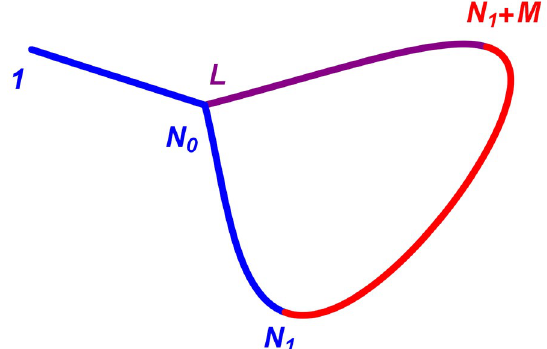
Figure 7. The nonuniform Ising-Kitaev chain with a T-junction. The chain contains two “topological” (blue and purple) regions and one “trivial” (red) region. The first “topological” region is characterized by the parameter < 1 and contains the first N λ 1 1 sites. The next M sites are occupied by the “trivial” phase with remaining portion of the chain of the length